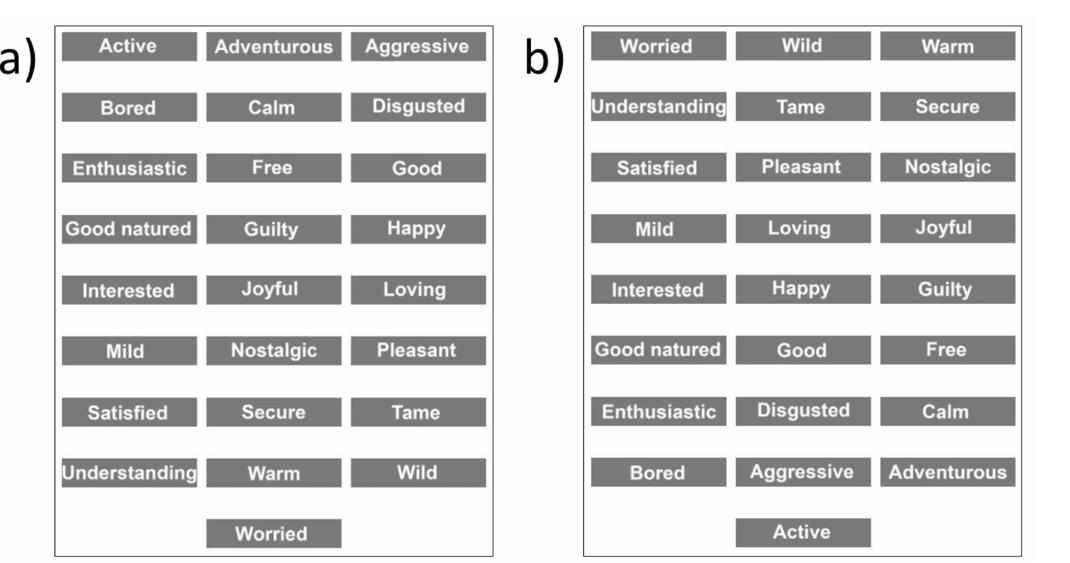
Figure 4. Screenshots of the EsSense25 word list in ( a ) alphabetical and ( b ) reversed order (from